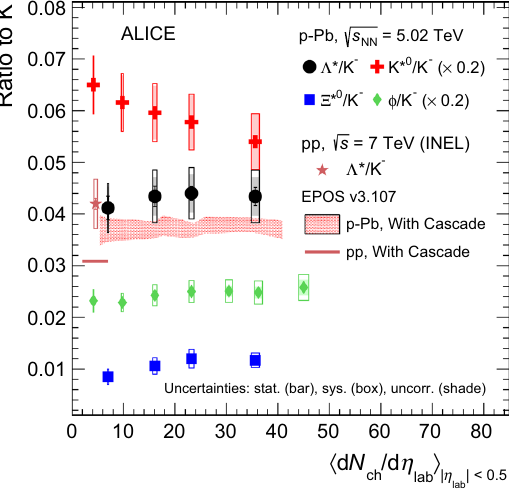
Fig. 7 Ratio of (cid:3) ∗ , K ∗ 0 , (cid:9) ∗ 0 and φ to charged π (left) and K − (right) √ s NN = 5 . 02 TeV as a function of the average in p–Pb collisions at charged-particledensity (cid:6) d N ch / d η lab (cid:7) measuredatmidrapidity[24,64]. Statistical uncertainties (bars) are shown together with total (hollow